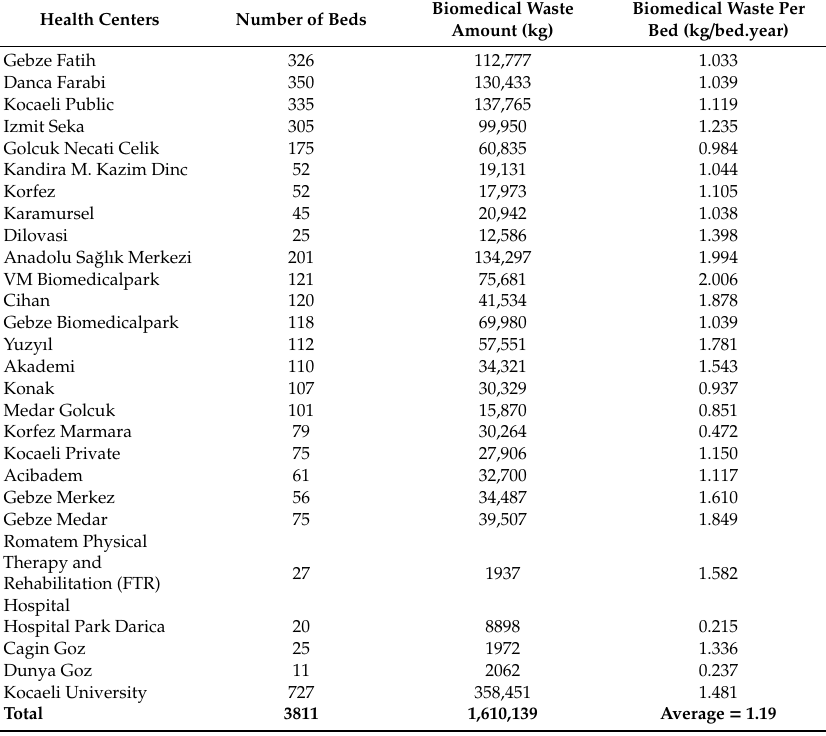
Table 1. Amounts of biomedical waste generated in Kocaeli city in 2019.